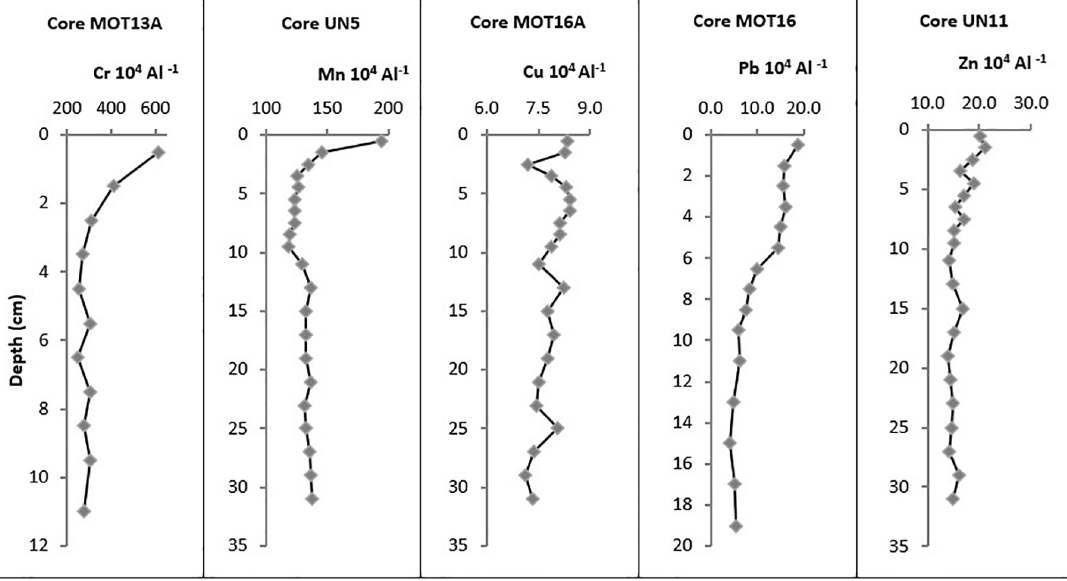
Figure 4. Vertical distributions of ratios to Al at cores MOT13A, UN5, MOT16A, MOT16 and UN11 in the northwestern Saronikos Gulf (profiles for MOT13A and MOT16 depict ratios calculated for the muddy